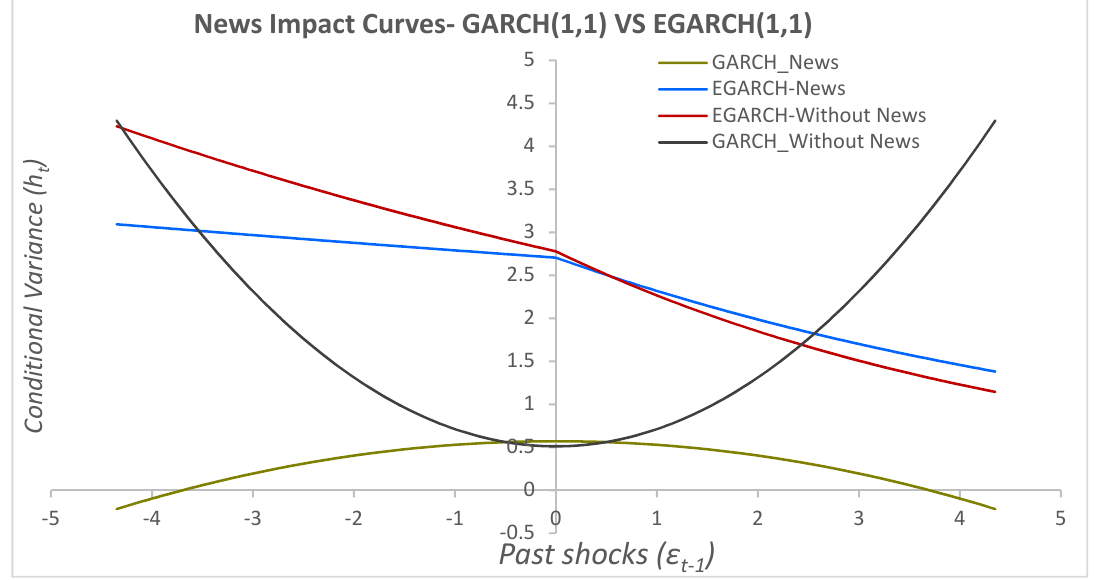
Figure 4. This figure shows the news impact curve in the GARCHX model with & without news and the EGARCH model. We use data of 197 stocks listed on S&P/ASX200 from 27 January 2020 to 30 December 2020 to examine the effect of COVID-19 on Australian stock returns and their volatility. VWR-ASX200 is the value-weighted return of 197 stocks listed in S&P/ASX200 at level; Oil Price is the international crude oil price to the order I(1), the Interest rate is Australian one-month interbank interest rate to the order I(1), COVID-19A represents the total number of confirmed cases in Australia due to COVID-19 to the order I(1), COVID-19B represents the total number of deaths in Australia due to COVID-19 to the order I(1), and COVID-19C is a dummy variable depicting the negative news, and it takes a value of 1 from 24 February 2020 to 22 March 2020 otherwise 0.